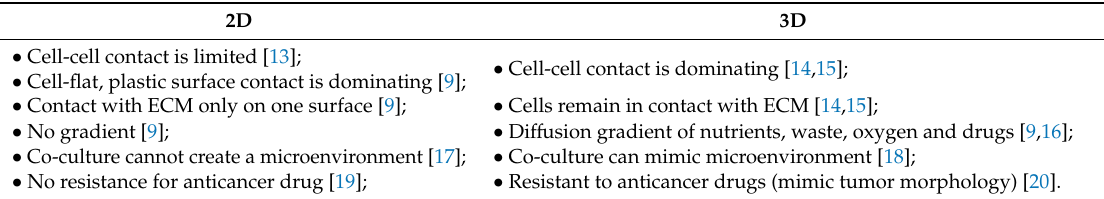
Table 1. Comparing of 2D and 3D cell